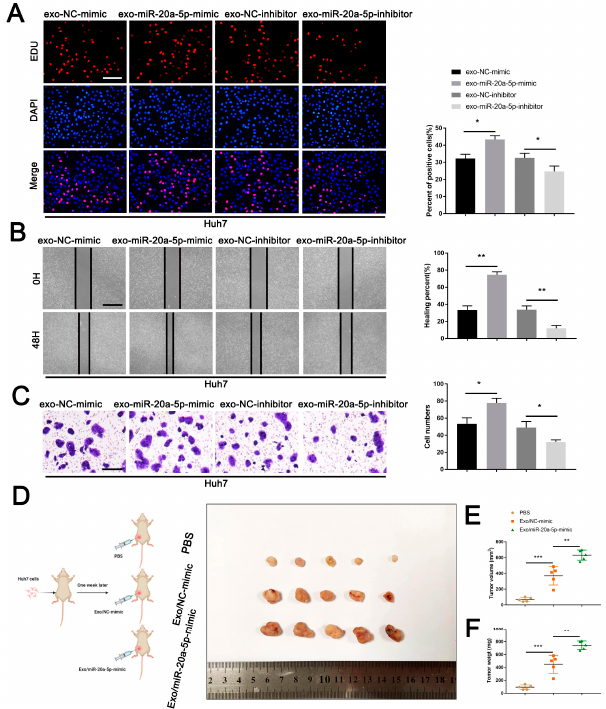
Figure 7. CAF-derived exosomes harbouring miR-20a-5p facilitated HCC progression. ( A ) EdU, ( B ) wound healing and ( C ) Transwell assays were performed to determine the effects of